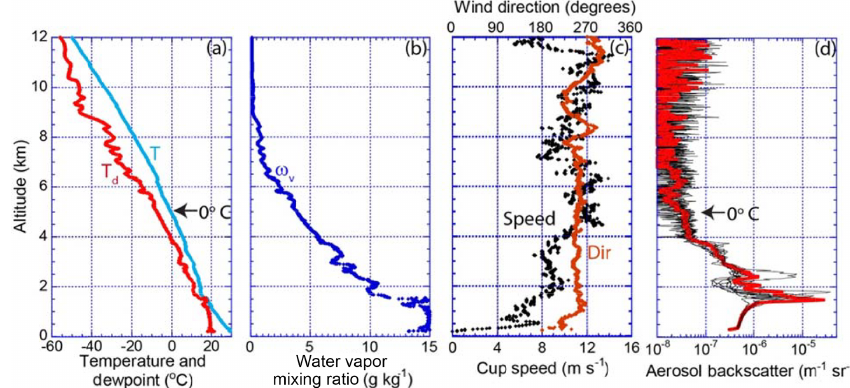
Figure 3. SEACIONS radiosonde release on 12 August 2013 18:40Z/13:40CDT at Huntsville (altitude in m.s.l., 200m greater than ground level). (a) Temperature and dew point; (b) water vapor mixing ratio; (c) wind cup speed and direction; (d) 5min aerosol backscatter